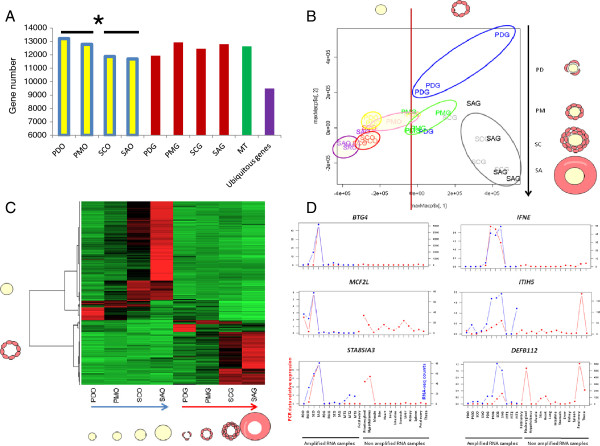
Global gene expression. A: Number of expressed genes. For each condition (stage x compartment) expressed genes are genes with an average expression >10 reads for ¾ of the replicates. Ubiquitous genes are genes expressed in all the samples. *: pval < 0.05 between PDO-PMO and SCO-SAO. B: Principal component analysis (PCA) of the transcriptome. PCA was performed on the gene data set after normalization using the R DEseq package. The first axis explains 52% of the expression variability and separates the two follicular compartments (O vs. GCs). The second axis explains 15% of the expression variability and separates the samples according to their follicular stages. C: Heatmap display of supervised hierarchical clustering of all the differential genes between compartments. The 1,694 genes are displayed in rows and the mean of replicates per condition are displayed in columns. Red, black and green represent up, mean, and down expression, respectively. D: Specific expression profiles. Relative quantification of BTG4 MCF2L, STA8SIA3 oocyte-specific genes and IFNE, ITIH5, DEFB112 GC-specific genes in the 2 follicular compartments and throughout early follicular development ((n = 3-4), Pd: primordial, Pm: primary, Sc: secondary, SA: small antrum). Expression specificity was checked by comparison with the expression of 3 amplified multi-tissue samples (3 independent pools of 12 tissues = MT) and non-amplified individual tissues. X axis from the left: PDO, PMO, SCO, SAO, PDG, PMG, SCG, SAG, MT1, MT2, MT3, fetal ovary, pituitary gland, hypothalamus, muscle, skin, hurt, lung, intestine, stomach, liver, kidney, spleen, fetal ovary, theca. The left Y axis corresponds to the relative expression normalized by 2 reference genes (Actin β and RPL19) from qPCR data (red color). The right Y axis corresponds to the normalized counts from RNA-seq data (blue color).